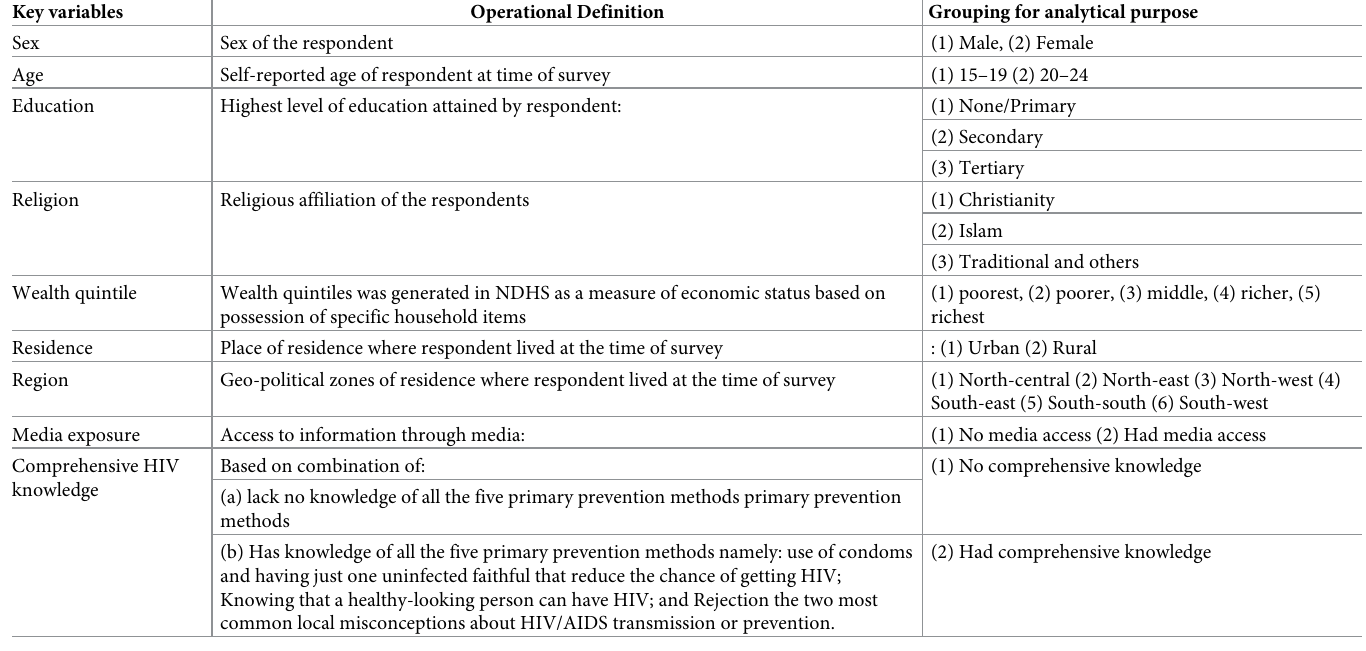
Table 1. Explanatory variables for modelling contraceptive use and sexual behaviour among young people in